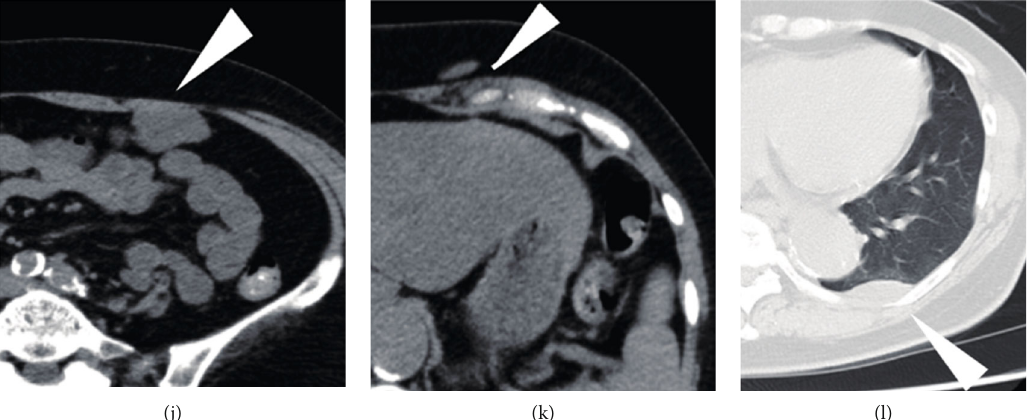
Figure 4: Response to chemotherapy in metastatic myxoid liposarcoma. Computed tomography (a – c) before and (d – f) after 3 cycles of trabectedin showing progressive disease. Partial response was obtained 5 months after treatment with eribulin (g – i). The tumors were under control for another 10 months (j –